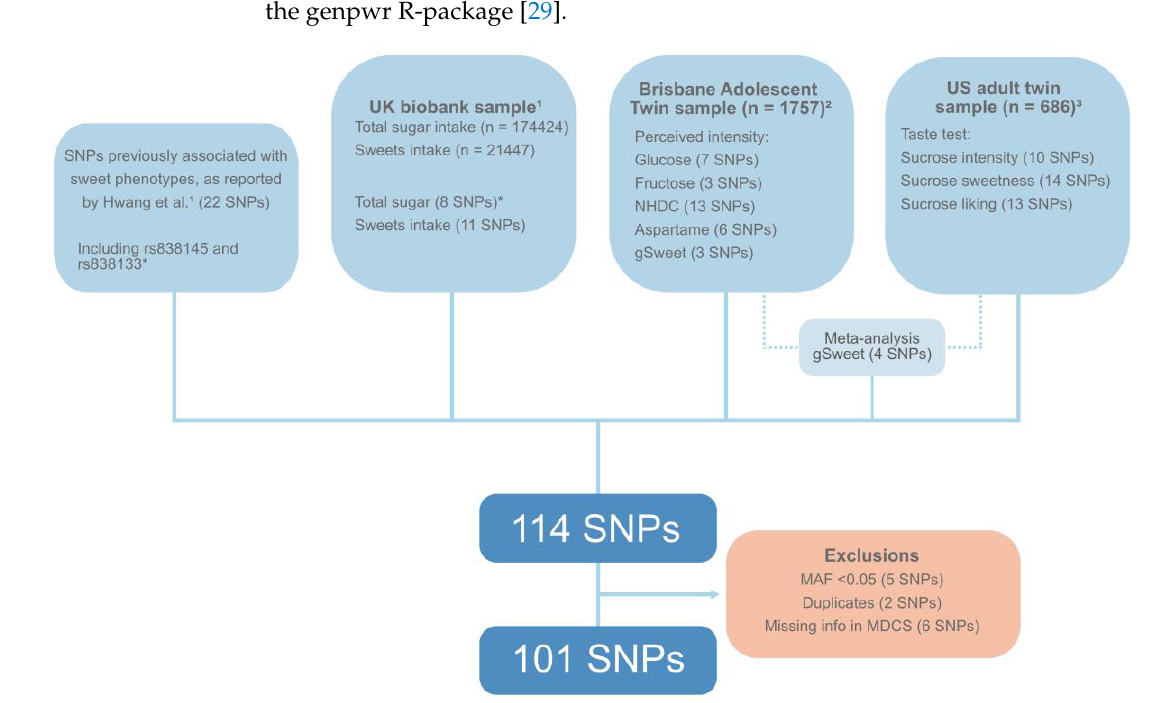
Figure 1. Description of all SNPs included in this study, based on a list compiled by Hwang et al. [16]. * Main SNPs in our study. 1 Hwang et al. [16]. 2 Hwang et al. [27]. 3 Knaapila et al. [26] SNPs: Single-nucleotide polymorphisms. MAF: Minor allele frequency. MDCS: Malmö Diet and Cancer Study. gSweet: Weighted mean of the glucose, fructose, NHDC, and aspartame intensity